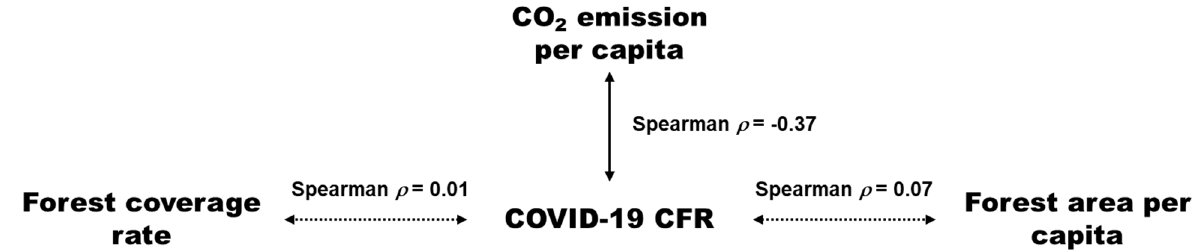
Figure 1. The relationships between forest coverage rage, CO 2 emission per capita, and COVID-19 CFR. Note: the solid line indicates significant linear correlation ( p < 0.05); the dotted lines indicate non-significant linear correlation ( p > 0.05).